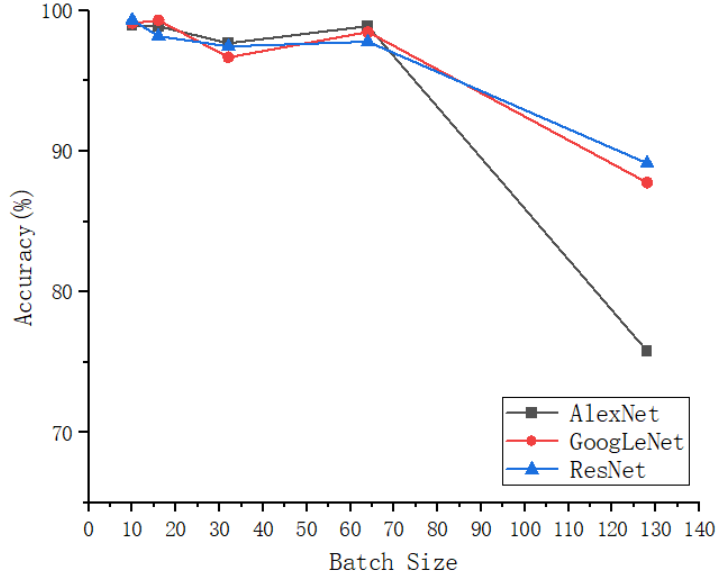
Figure 17. Effect of batch